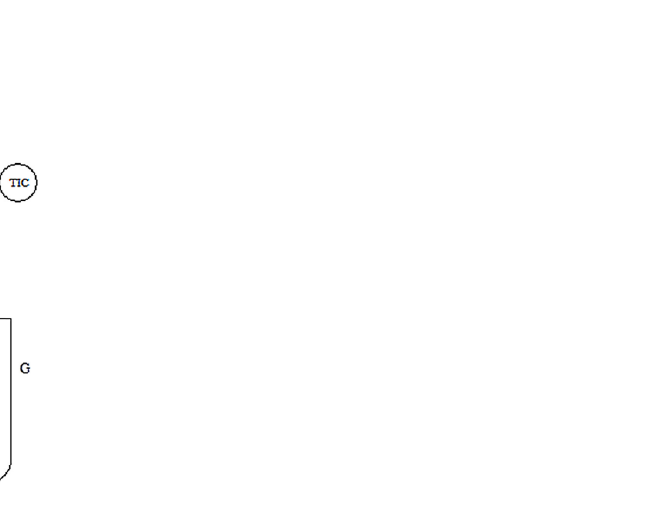
Figure 2. Laboratory apparatus for micronization with the PGSS (particles from gas-saturated solutions) process (A, carbon dioxide reservoir; B, valve; C, high-pressure pump; D, safety drive; E, autoclave; F, nozzle; G, expansion chamber; PI, analog manometer; TIC, thermo element with digital screen) (reprinted from The Journal of Supercritical Fluids , 103, Tina Perko, Matej Ravber, Željko Knez, Mojca Škerget , Isolation, characterization and formulation of curcuminoids and in vitro release study of the encapsulated particles, 4, Copyright (2022), with permission from Elsevier) .